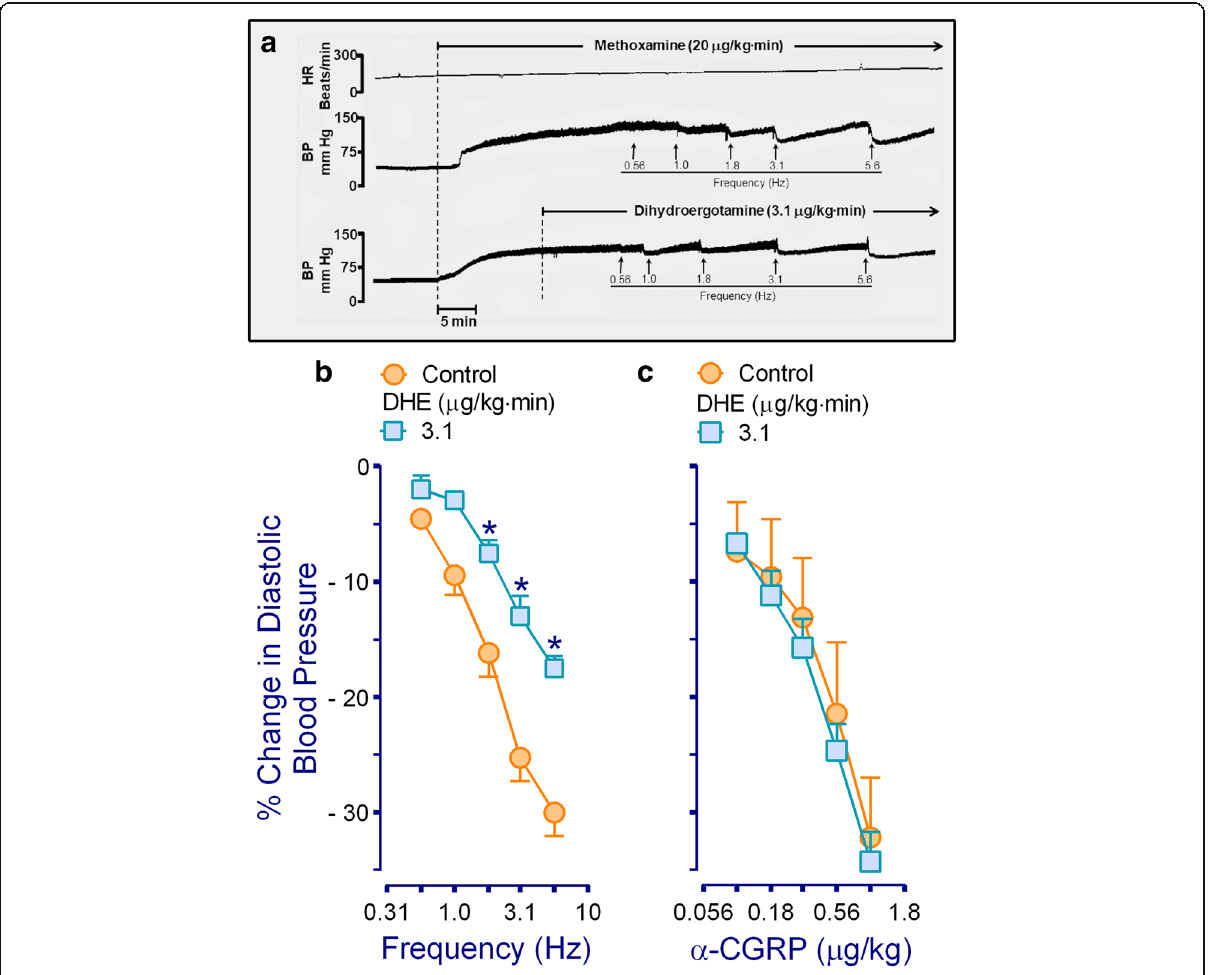
Fig. 1 Effect of dihydroergotamine (DHE) on the vasodepressor CGRPergic outflow in pithed rats. a Original experimental tracings illustrating the vasodepressor responses induced by electrical stimulation of the perivascular sensory CGRPergic outflow during continuous infusions of either methoxamine (control; above) or DHE (below). Note that during continuous infusions of DHE (3.1 μ g/kg·min) the vasodepressor responses induced by electrical stimulation were attenuated versus control. In both cases, the vasodepressor responses were selective as no changes in heart rate were observed. Panels ( b ) and ( c ) show the vasodepressor responses by electrical stimulation or i.v. bolus injections of α -CGRP, respectively, induced during an i.v. continuous infusions of 3.1 μ g/kg·min DHE ( n =5 each). For the sake of clarity, control responses ( ○ ) were induced